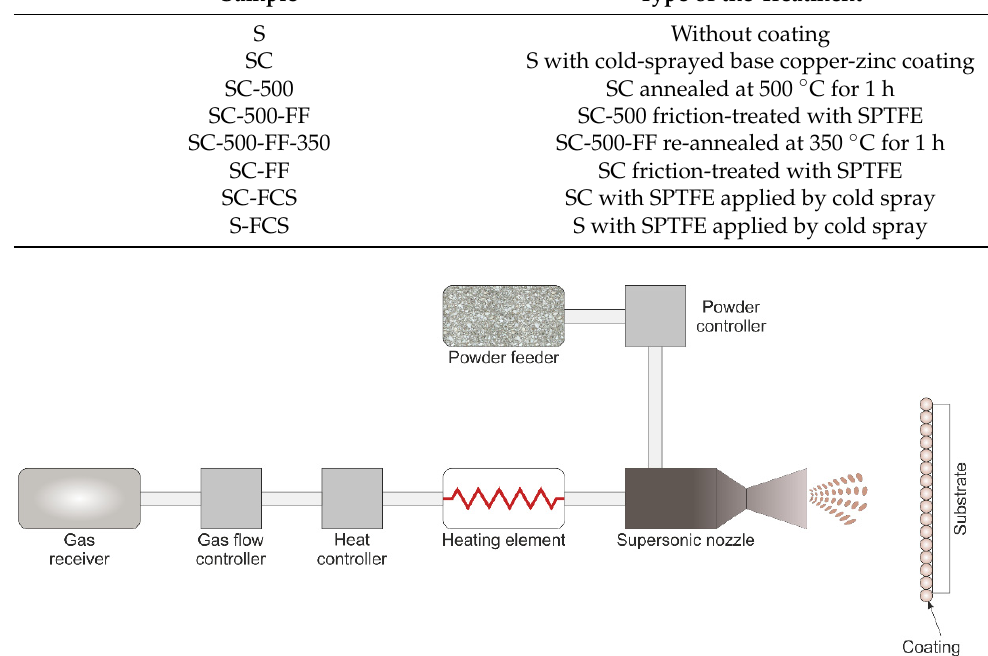
Figure 2. Scheme of the cold spray DIMET ® equipment.